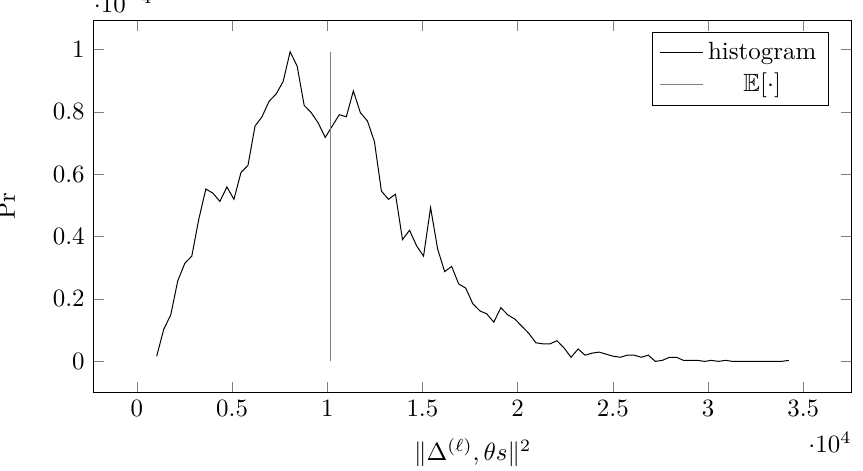
Figure 2: Histogram of observed squared norms of vectors of length n = 256 mod q = 7681, folded three times to dimension 32, written in base 2 7 , for θ = 3 and κ = 19. Note